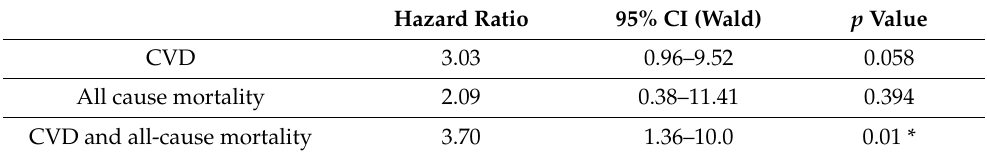
Table 3. Hazard ratio for occurrence of new events for CVD and all-cause mortality